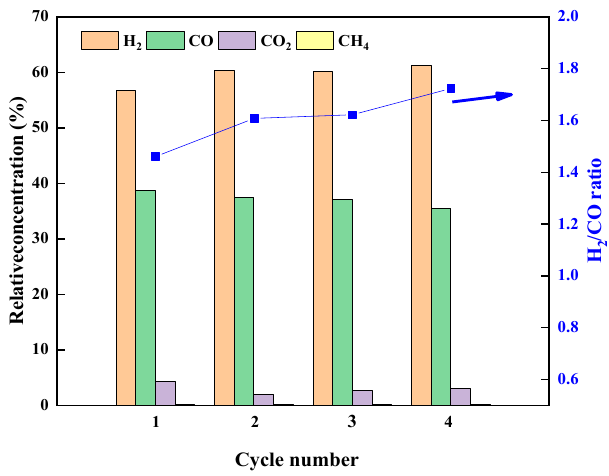
Figure 8. The influence of cycle number on relative concentration of gas products and H 2 /CO.